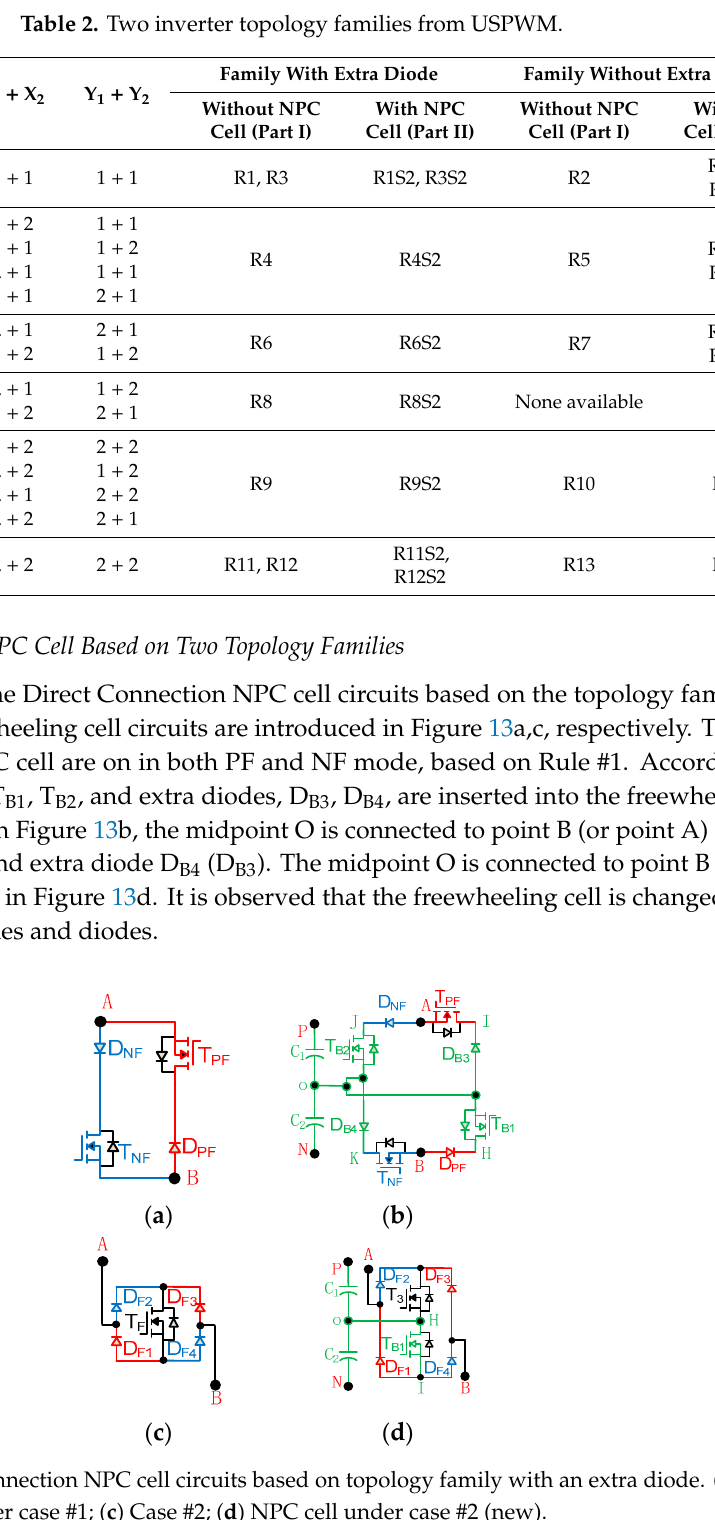
( c ) Figure 14. Direct Connection NPC cell circuits based on topology family without an extra diode. ( a ) freewheeling circuit; ( b ) NPC cell #1; ( c ) NPC cell #2. 4.2. M = 2, N = 2 In order to show how the Direct Connection NPC topology R2S2 is derived based on HERIC topology R2, it is illustrated in Figure 15. According to Rule #1, switches T P3 and T N3 are on in PF and NF modes. As shown in Figure 15b, two extra switches, T B1 and T B2 , are inserted so that point B or point A is clamped to point O based on Rule #2. In Figure 15c, two extra diodes, D B2 and D B3 , and one extra switch, T B1 , are inserted to guarantee that point B is clamped to point O.